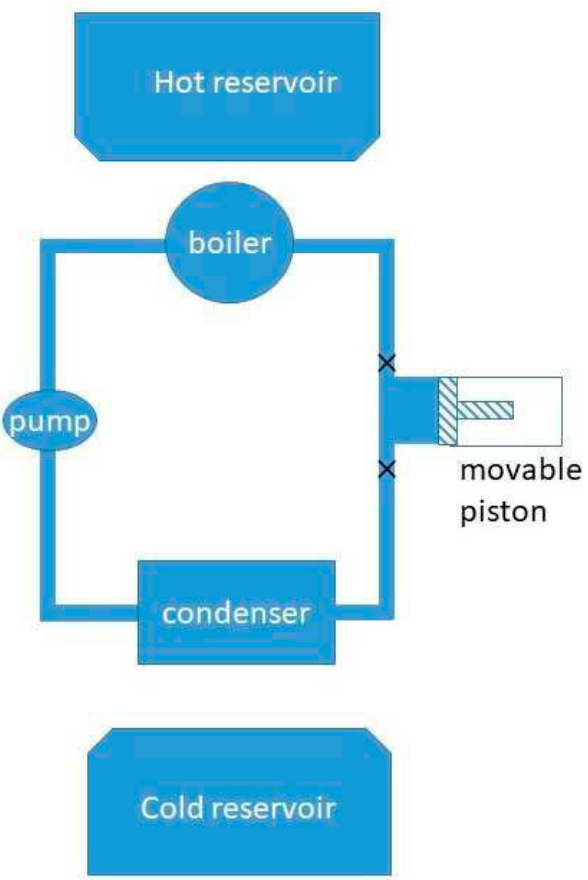
Figure 3. Schematic representation of the steam engine.